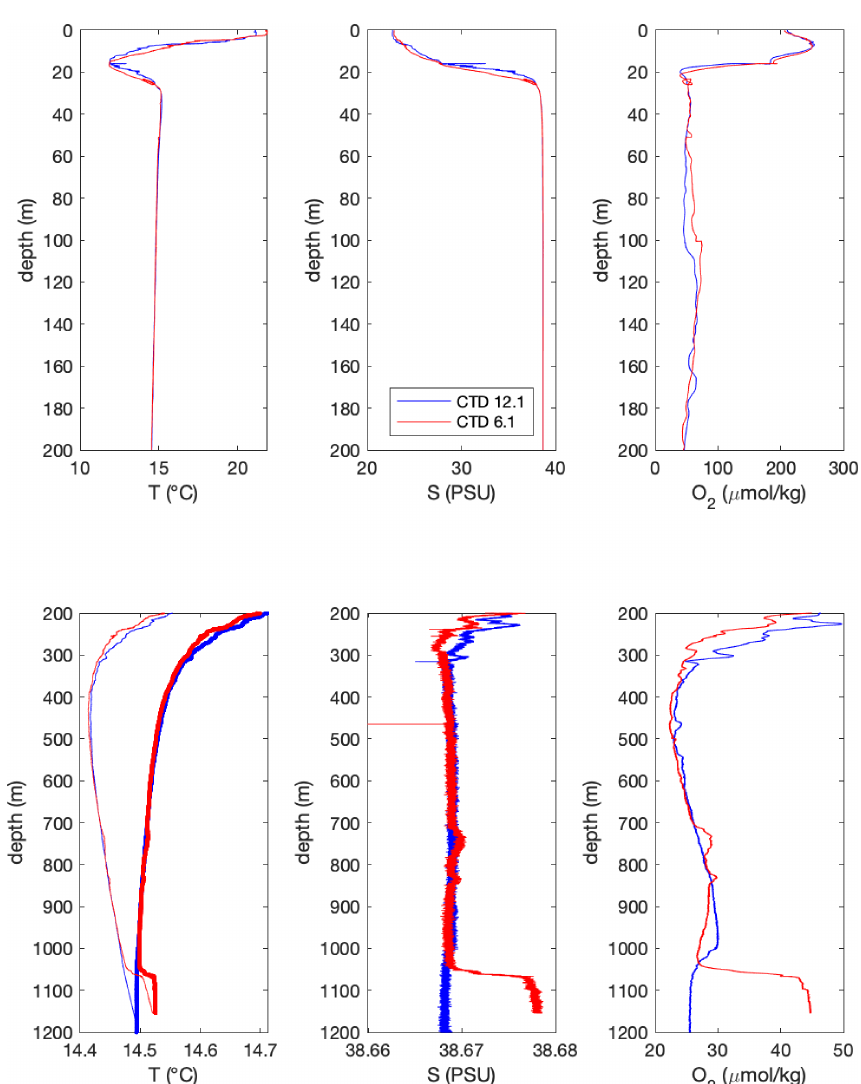
Figure 8. Depth plots of temperature ( T , ◦ C), salinity ( S , PSU, practical salinity unit) and oxygen concentration (O 2 , µmolkg − 1 ) from CTD profiles acquired in the Sea of Marmara in June 2007 during the Marnaut cruise of Ifremer’s (Institut Français de Recherche pour l’Exploitation de la Mer) R/V L’Atalante (Henry et al., 2007). On the lower temperature plot, thin lines are measured values and thick lines are conservative temperatures calculated at 1180m. Locations are shown in Fig.